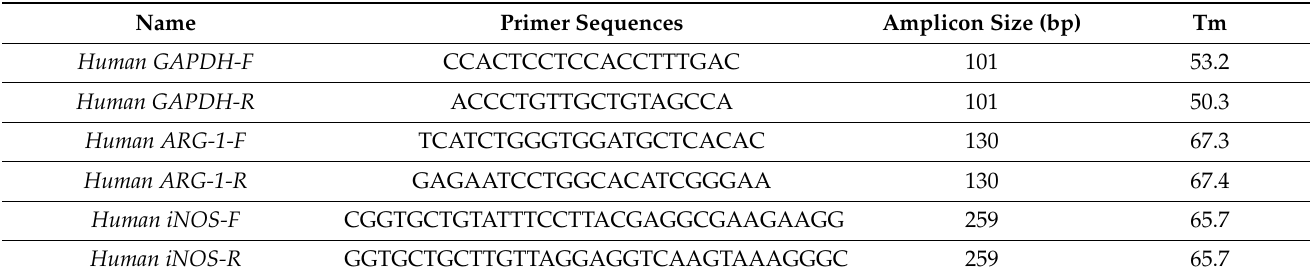
Table 1. The primer sets of quantitative polymerase chain